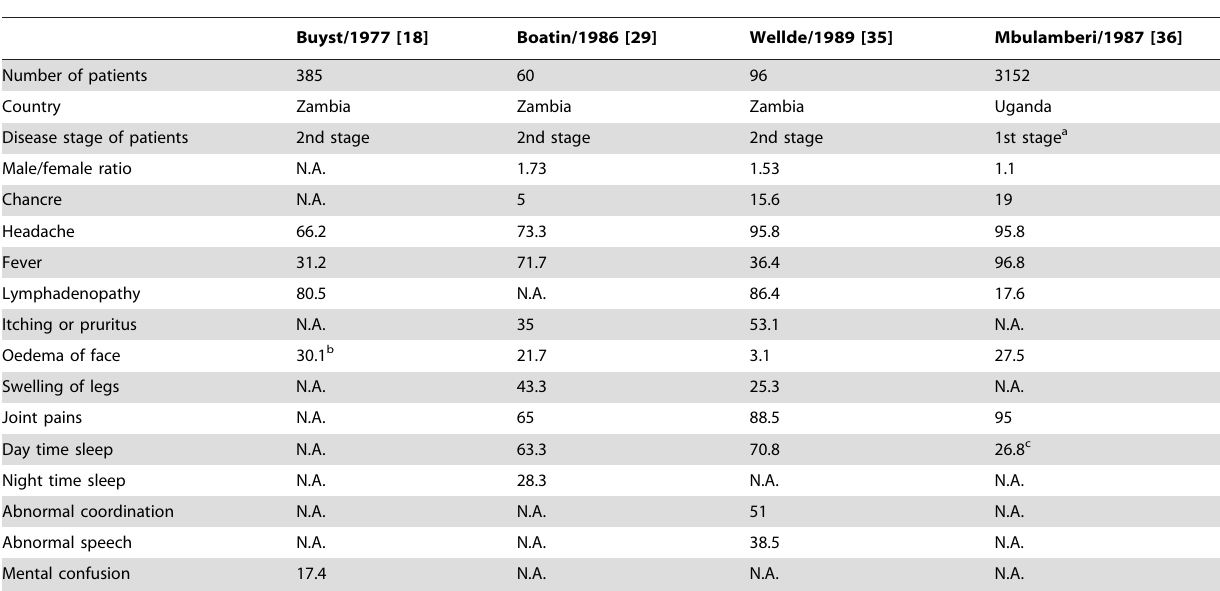
Table 1. Published literature on clinical signs & symptoms of T.b. rhodesiense HAT.